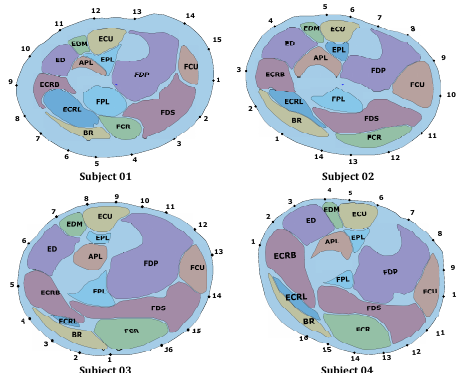
Figure 6. Results of the segmentation on muscles and registration of electrodes position on the 2D image plane of the MRI slice. In each MRI slice the following muscles can be identified: Abductor Pollicis Longus (APL), Extensor Pollicis Longus (EPL), Brachioradialis (BR), Extensor Digitorum (ED), Extensor Carpi Radialis Longus (ECRL), Extensor Carpi Radialis Brevis (ECRB), Extensor Carpi Ulnaris (ECU), Extensor Digiti Minimi (EDM), Flexor Digitorum Profundis (FDP), Flexor Digitorum Superficialis (FDS), Flexor Carpi Ulnaris (FCU), Flexor Carpi Radialis (FCR).